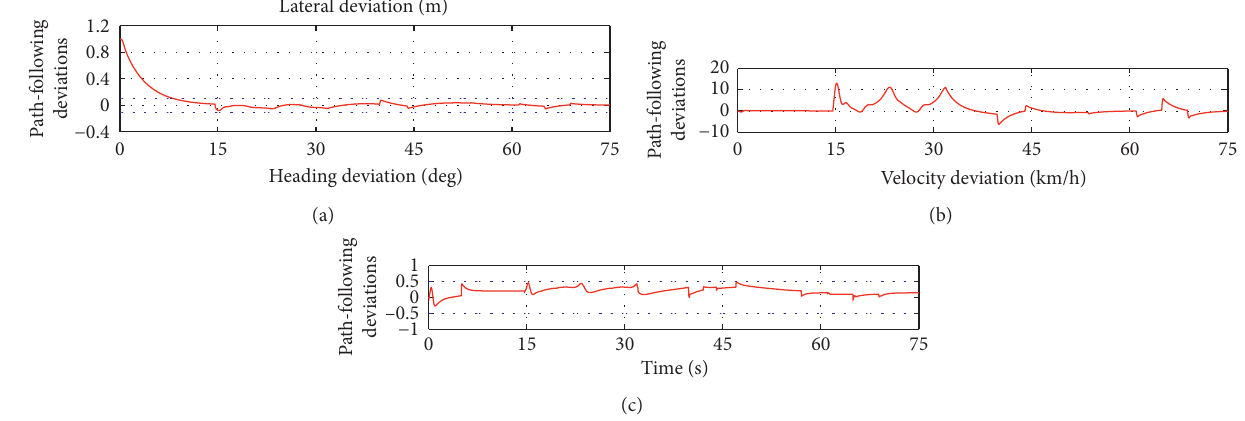
Figure 19: Time histories for three deviations of the vehicle under the path-following control.